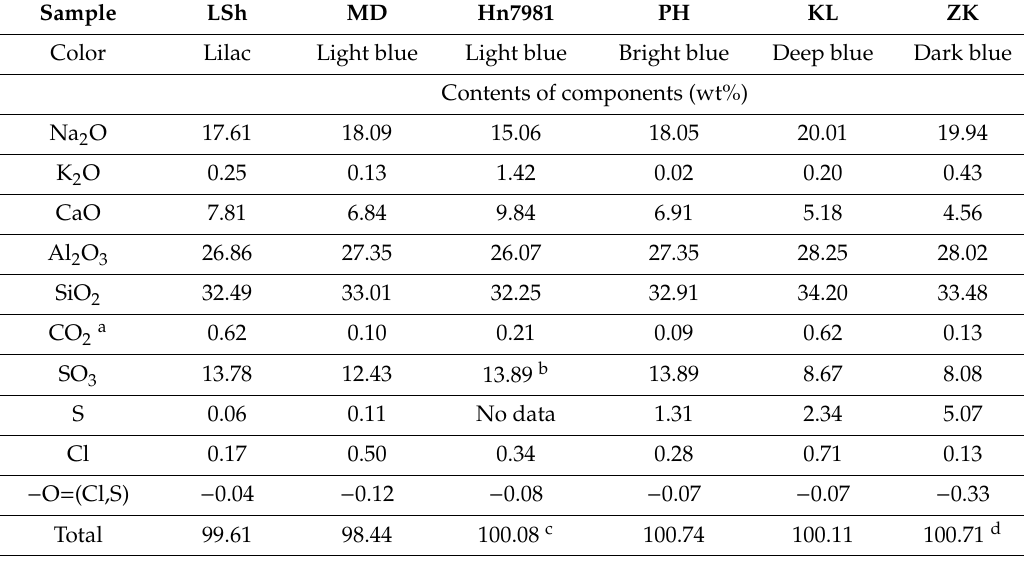
Table 1. Chemical composition of sodalite-group